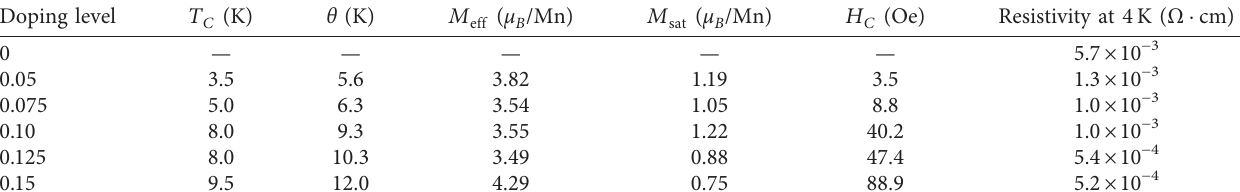
M , saturation moment M eff